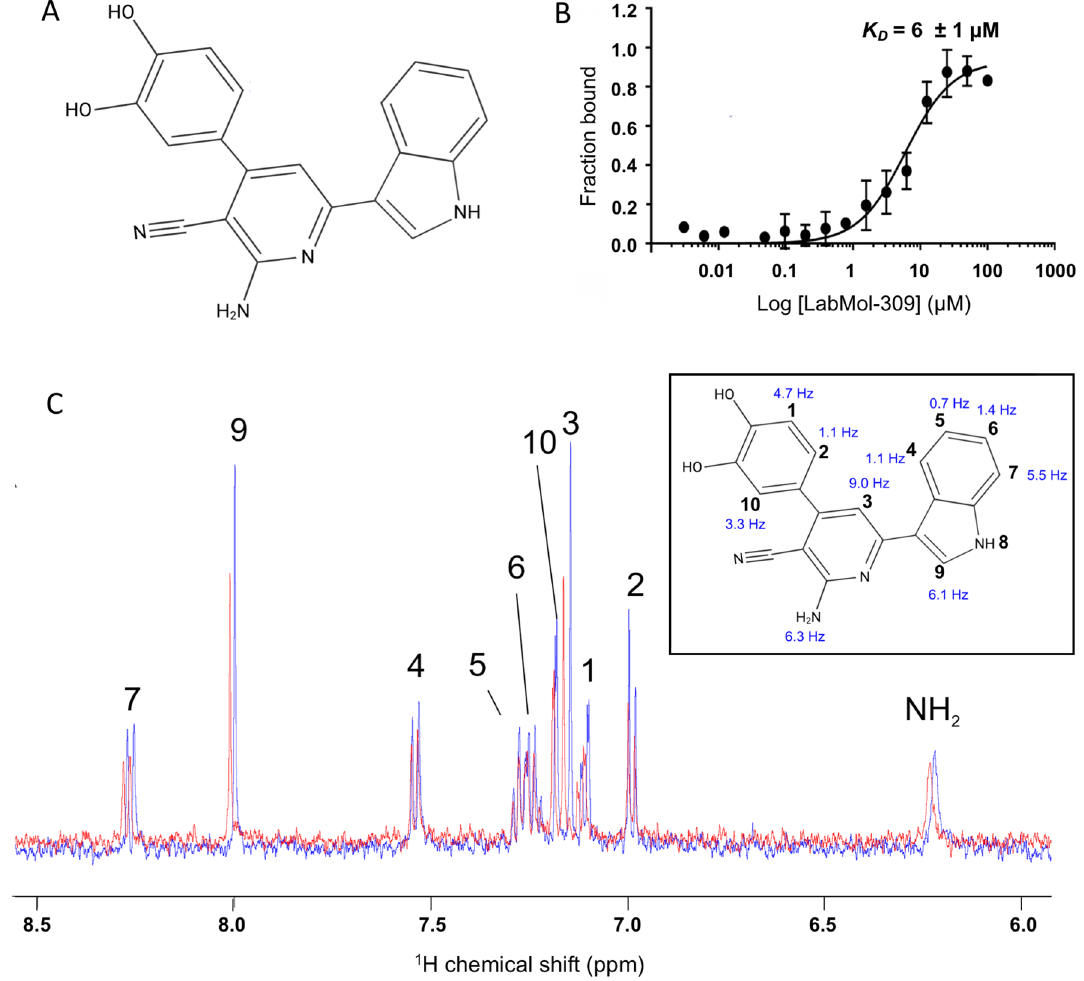
Figure 2. Evaluation of nsp4-CHIKV interaction with the compound LabMol-309. ( A ) LabMol-309 chemical structure. ( B ) Binding affinity curve of nsP4-CHIKV interacting with LabMol-309 by MST. The compound LabMol-309 was titrated in a concentration range of 200 µM to 0.012 µM. The curve was fitted to the Hill function, and the estimated K D was (6 ± 1 µM). ( C ) Chemical shift perturbation analysis based on the superimposition of LabMol-309 one-dimensional 1H spectra obtained in the presence (red line) and the absence of nsP4-CHIKV (blue line). On the right, chemical shift differences were measured (in Hz) for each proton of the LabMol-309